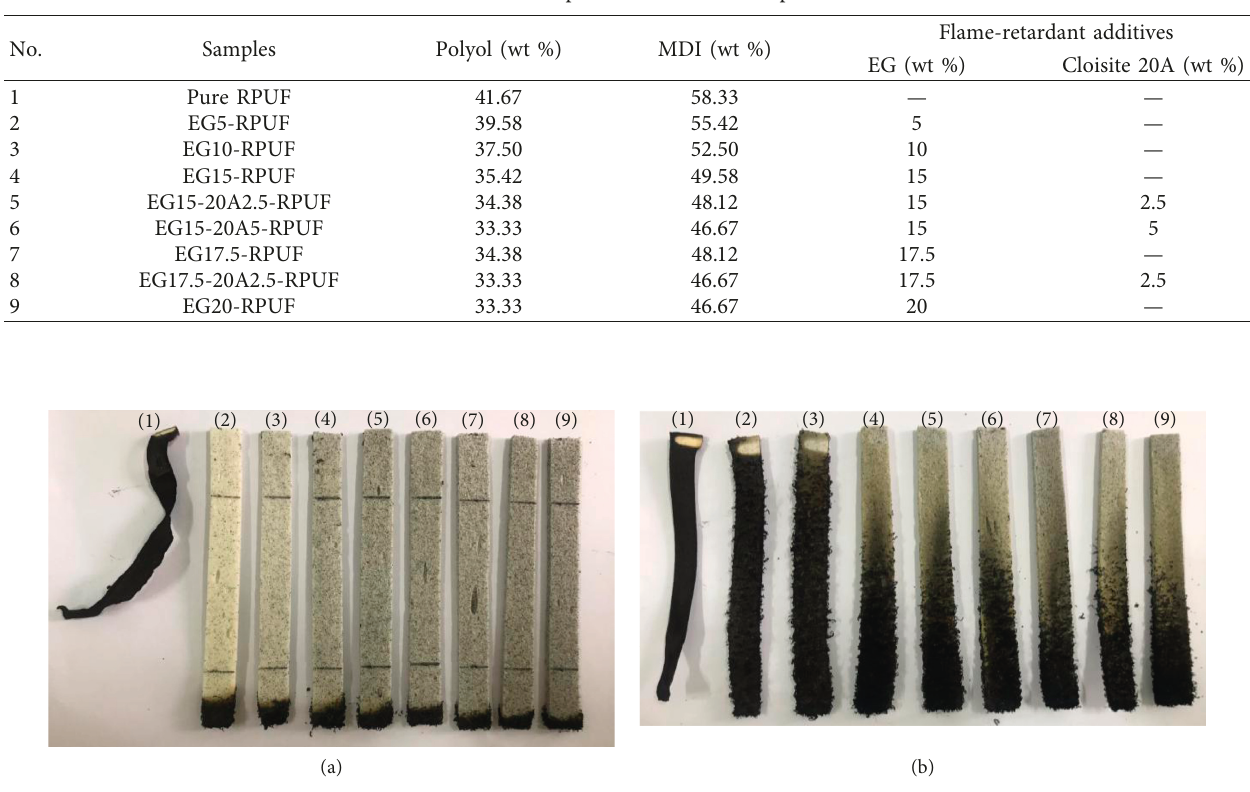
Figure 1: Images of the samples after the horizontal (a) and vertical burning tests (b): (1) pure RPUF; (2) EG5-RPUF; (3) EG10-RPUF; (4) EG15-RPUF; (5) EG15-20A2.5-RPUF; (6) EG15-20A5-RPUF; (7) EG17.5-RPUF; (8) EG17.5-20A2.5-RPUF; (9) EG20–RPUF. Table 2: Flame-retardant and physical properties of RPUF composites.